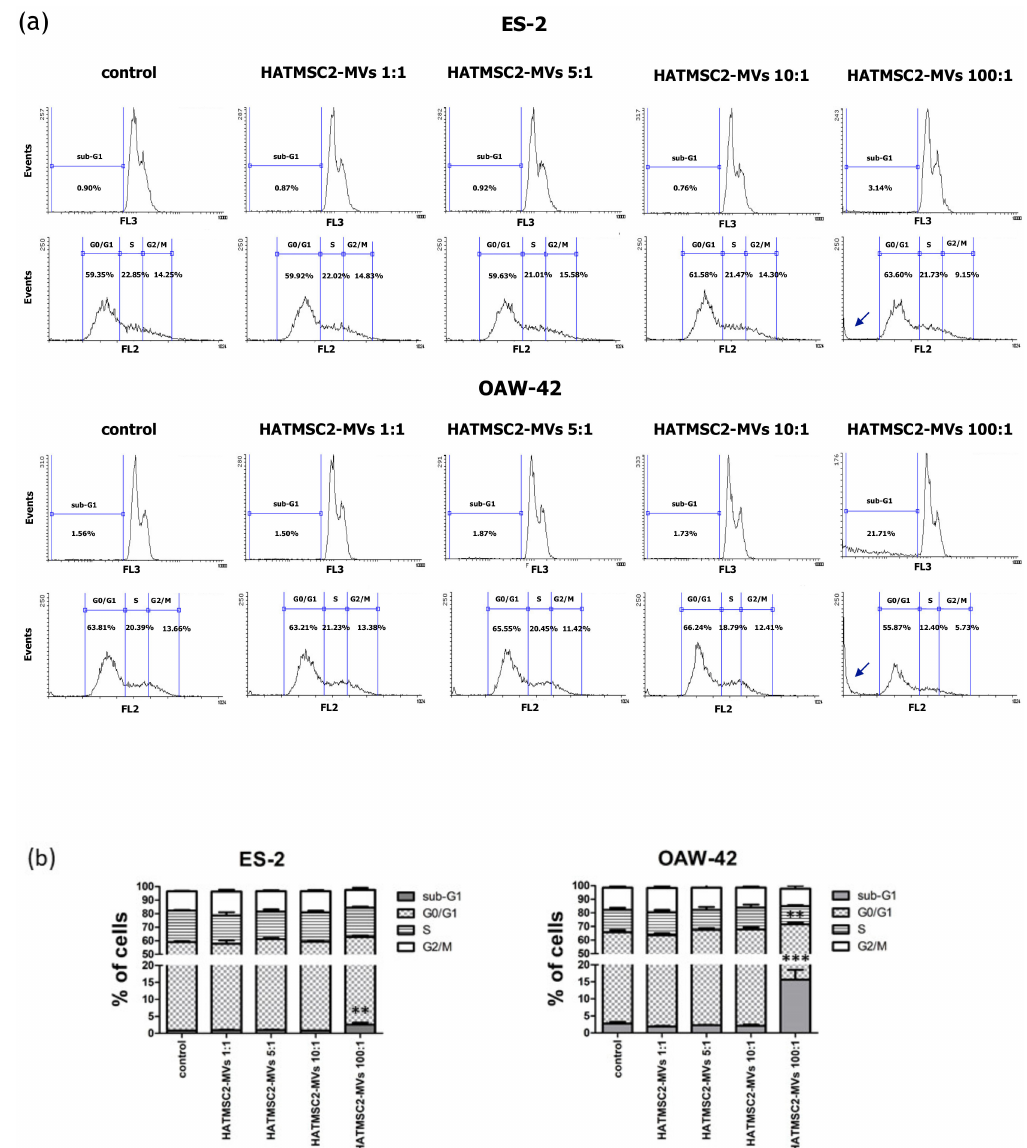
Figure5. E ff ectofHATMSC2-MVsonthecellcycleprogressionofovariancancercells. ( a )Representative flow cytometry histograms showing cell cycle progression in ES-2 and OAW-42 cells treated with HATMSC2-MVs at di ff erent ratios. Untreated cells without MVs served as a control. Arrows represent the increased peaks in the sub-G1 phase of the cell cycle. ( b ) Percentages of cells in the sub-G1, G0 / G1, S, and G2 / M phases were determined using Flowing Software 2. The data represent mean ± SEM values from three independent experiments performed in duplicate. *** p < 0.001, ** p < 0.01 calculated vs. control. HATMSC2-MVs—microvesicles derived from immortalized human mesenchymal